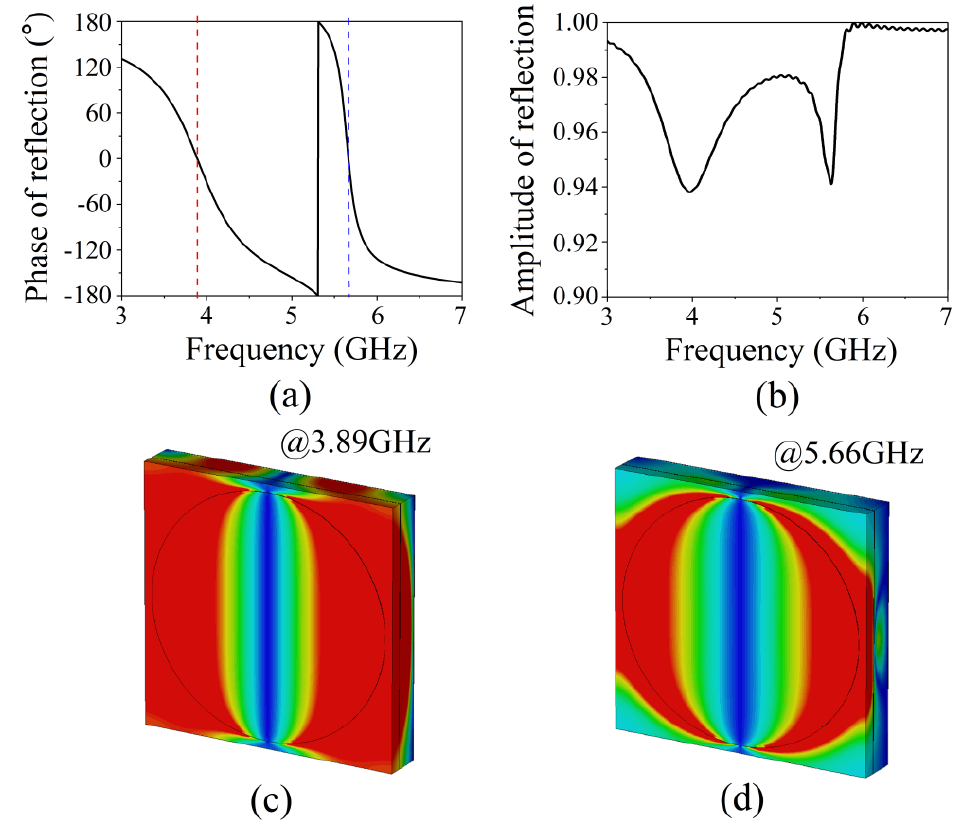
Figure 3. ( a ) Simulated reflection amplitude of a unit cell. ( b ) Simulated reflection phase of a unit cell. ( c ) Simulated electric field distribution at ( c ) 3.89 GHz and ( d ) 5.66 GHz.